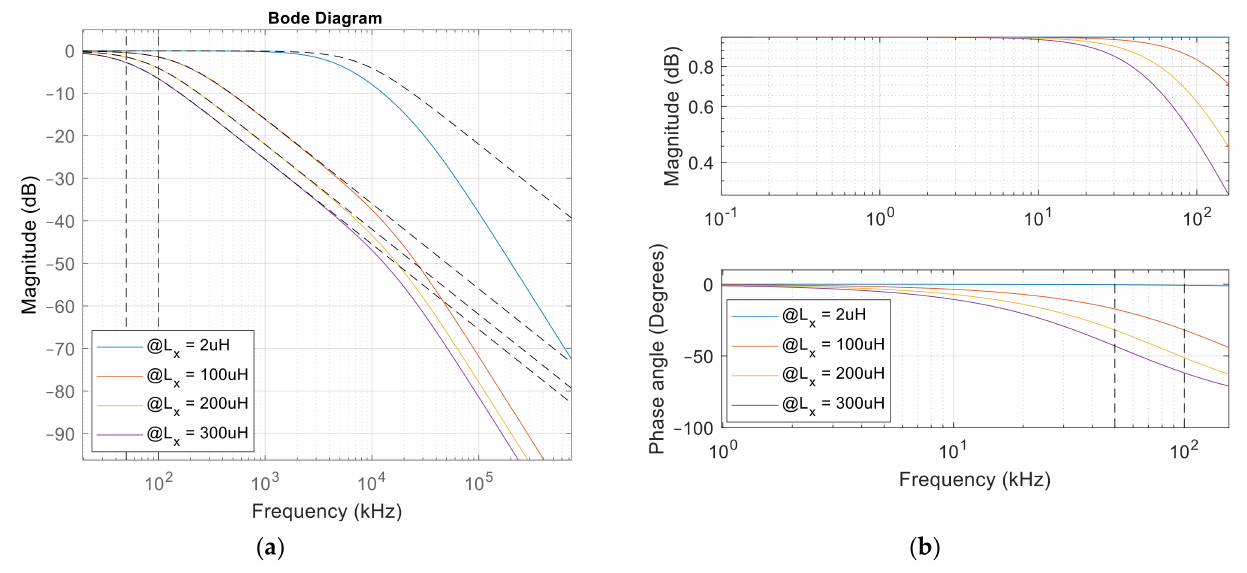
Figure 7. Bode plot of the measurement circuit at different inductances. ( a ) Bode plot of the extended transfer function, ( b ) Bode plot of the simplified transfer